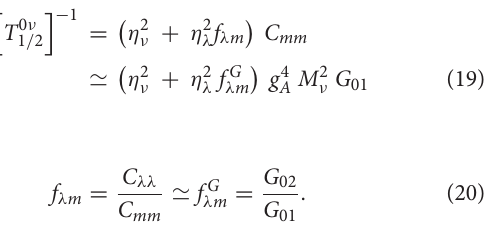
, M 2 ( λ mechanism) and M ν ( m ββ mechanism) of the 0 νββ + −